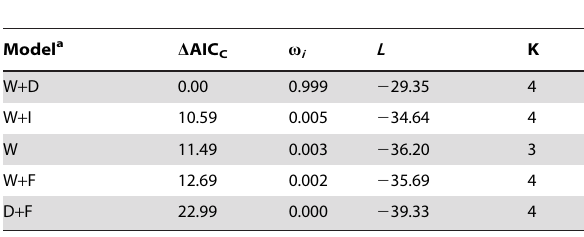
Table 3. Most-supported models of avian mortality resulting from window collisions at 20 buildings in Illinois, USA,